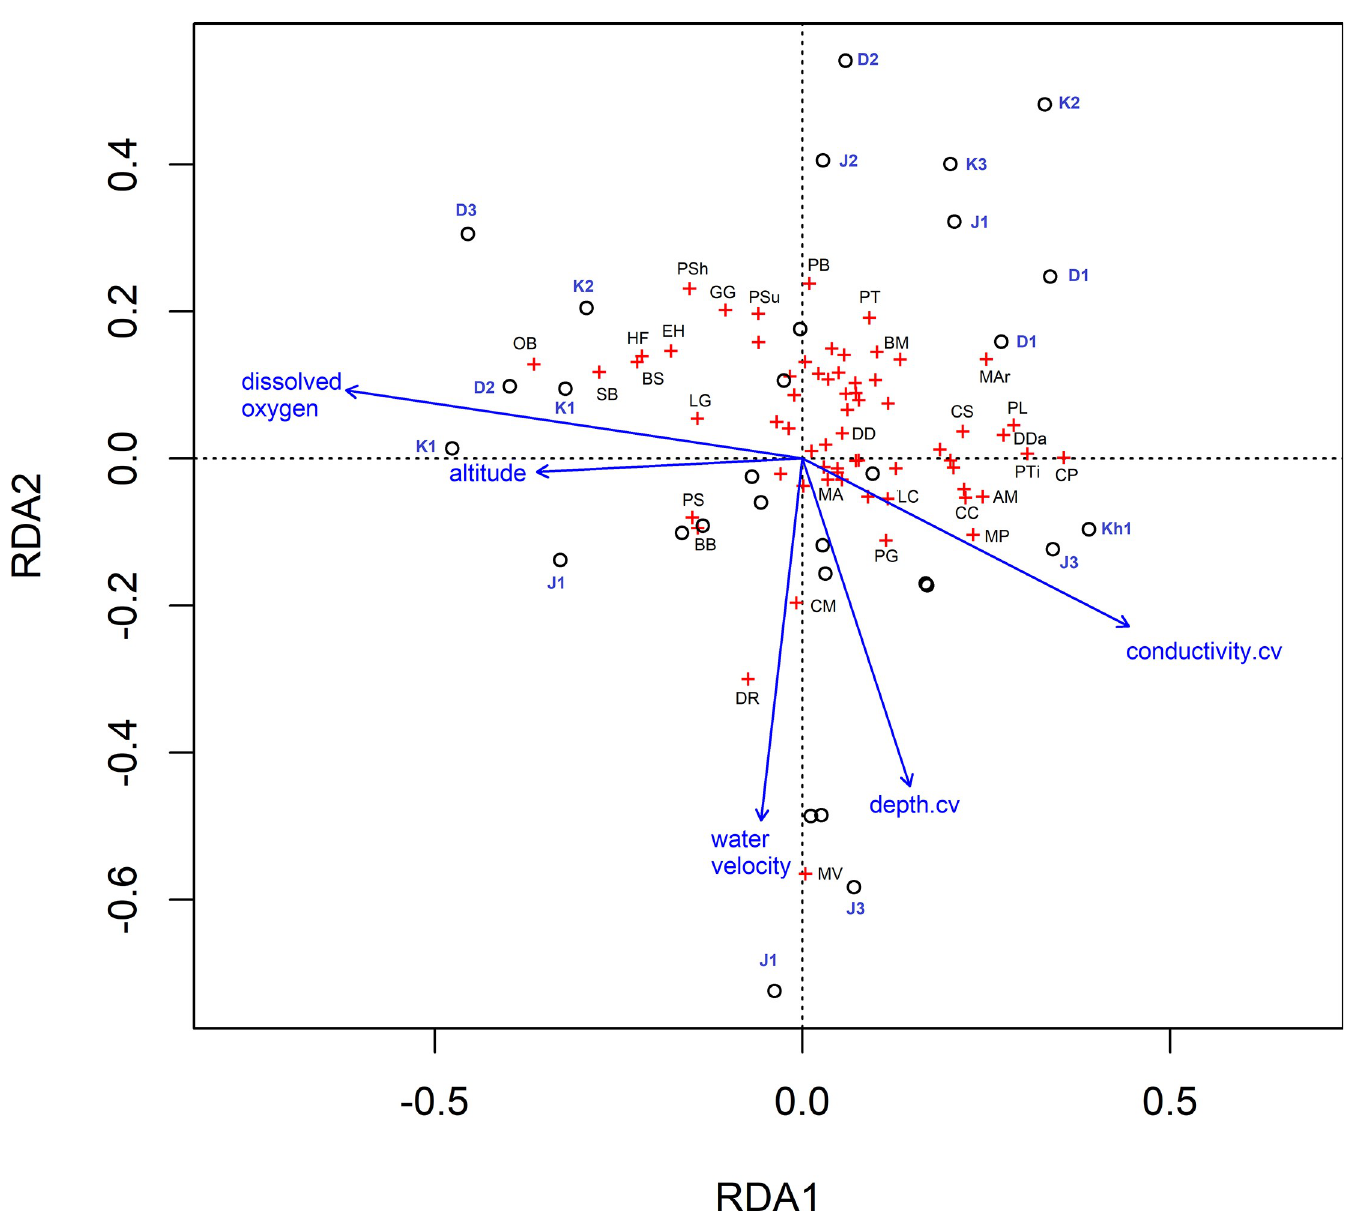
Fig 5. Redundancy analysis of 30 fish assemblages and environmental factors in West Bengal. Only the factors which were chosen after forward selection related to alpha diversity are shown on the plot above. Individual assemblages are denoted by black circles accompanied by site name in bold blue text (details in Table 2) and species by red crosses accompanied with initials of species names in black. Vector arrows are labelled with the corresponding environmental factor, and the length of the arrows indicates the relative strength of the relationship between that factor and assemblage structure. Legend for species names: OB = Ompok bimaculatus; SB = Schistura beavani; BS = Barilius shacra; HF = Heteropneustes fossilis; EH = Erethistes hara; LG = Lepidochephalichthys guntea; PSh = Pseudolaguvia shawi; GG = Glossogobius giuris; PSu = Psilorhynchus sucatio; PB = Paracanthocobitis botia; PT = Puntius terio; BM = Barilius modestus; MAr = Mastacembelus armatus; CS = Channa striata; PL = Parambassis lala; DDa = Danio dangila; PTi = Pethia tictio; AM = Amblypharymgodon mola; CC = Chitala chitala; MP = Macrognathus pancalus; CP = Channa punctata; LC = Leiodon cutcutia; MA = Macrognathus aculeatus; PG = Pethis gelius; CM = Clarias magur; DR = Danio rerio; BB = Barilius bengalensis; PS = Puntius sophore